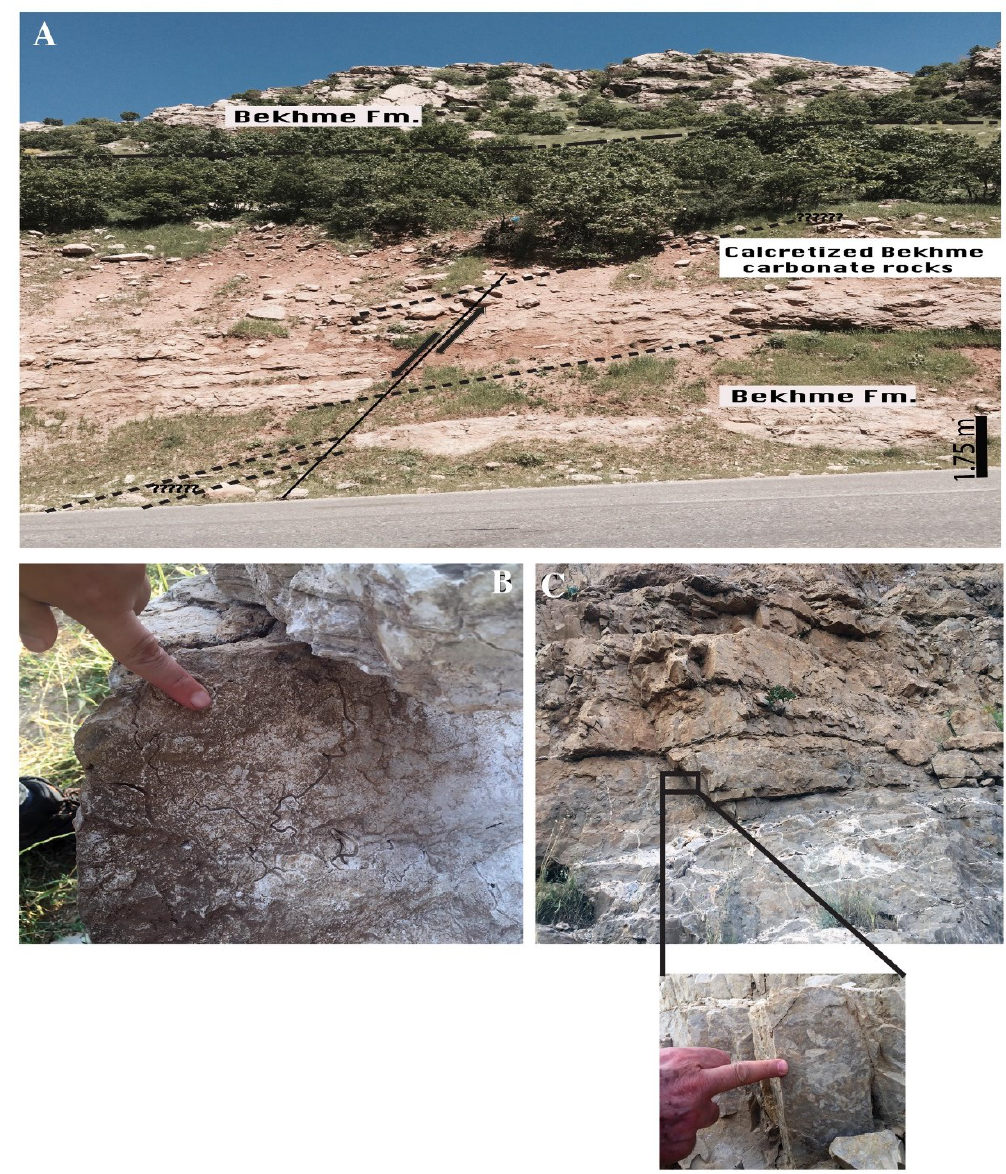
Figure 7. ( A ) Local fault slipping down the basal outcropped part of Bekhme carbonate and the calcrete level covered by the upper and lower Bekhme carbonate. Sulauk section. ( B ) Disturbed part, related to a burrowed zone in the muddy white dark laminated layers (see photograph C), with intense bioturbation and low diversity of ichnofossils, indicating a tide-dominated channel. Sulauk section. ( C ) Hydrofracturing in the gray dolomitic limestone from the lower part of the photograph leading to the formation of fragments. The associated fractures and voids are filled by hydrothermal products (saddle dolomite, see text). Sulauk section.